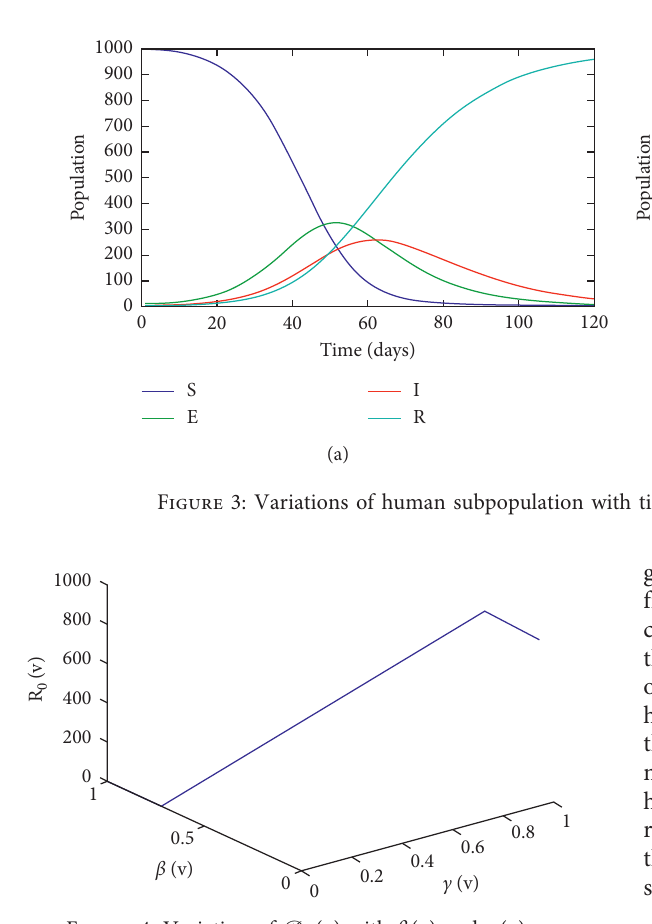
( v ) with β ( v ) and c ( v ) 0